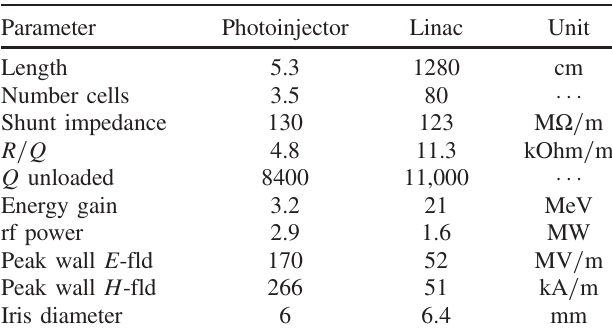
TABLE V. Parameters for linac and photoinjector structures. Parameter